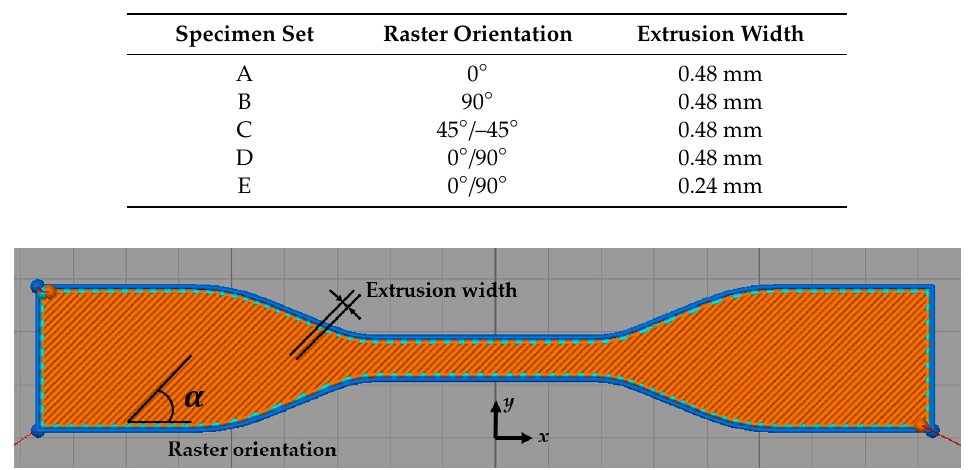
Table 1. Process parameter sets for fabricating the tensile specimens.